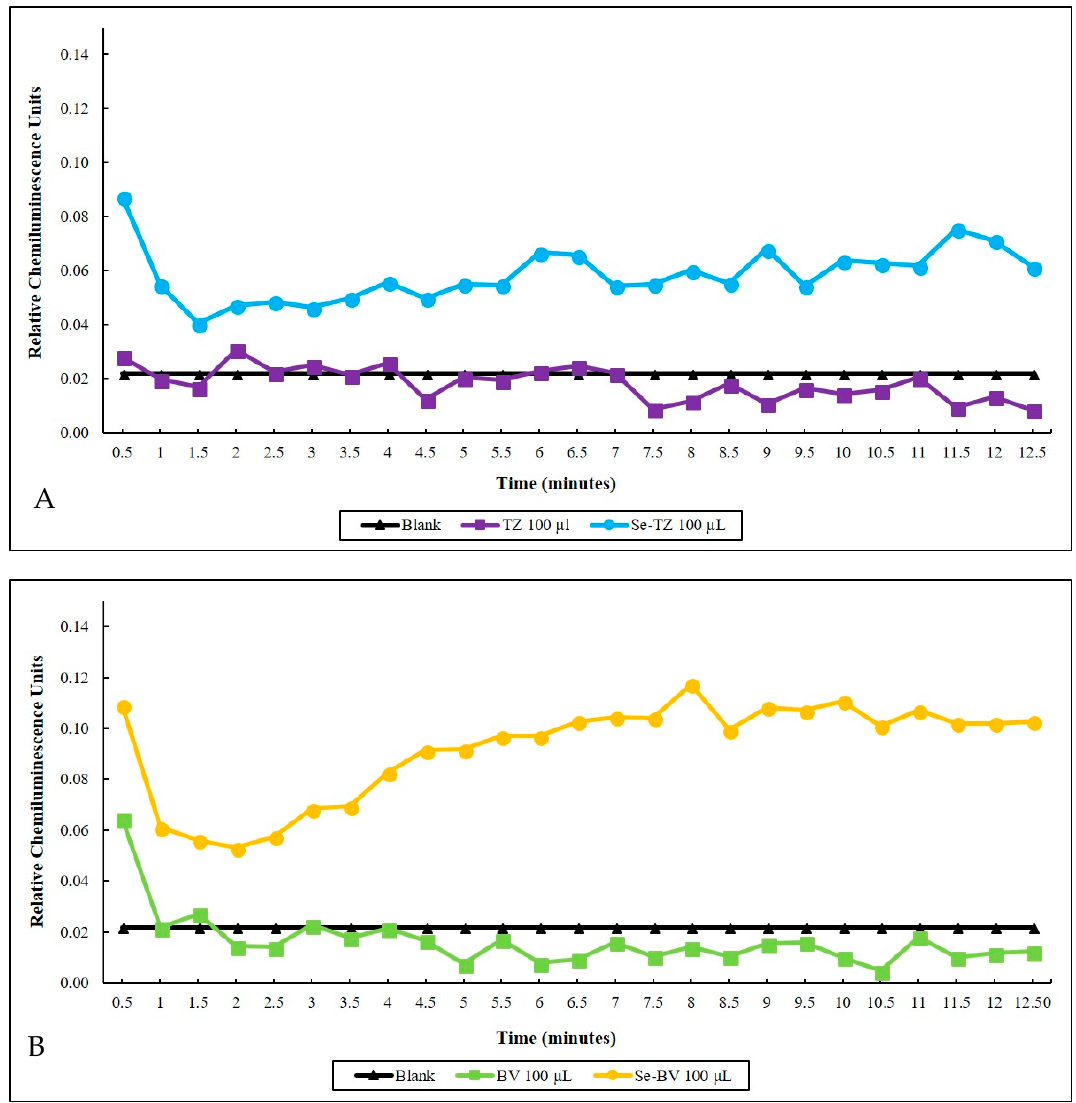
Figure 5. Time-dependent superoxide generation as measured by lucigenin chemiluminescence (CL). ( A ) Blank 100 µL Trastuzumab and 100 µL of Selenotrastuzumab = 8.8 µg of Se were compared. Proteins alone were further suppressive of the background (Blank CL) due to the slow auto-oxidation of GSH. ( B ) Blank 100 µL Bevacizumab and 100 µL Selenobevacizumab = 8.1 µg of Se. Proteins and BV alone were further suppressive of the background (Blank CL) due to the slow auto-oxidation of GSH.